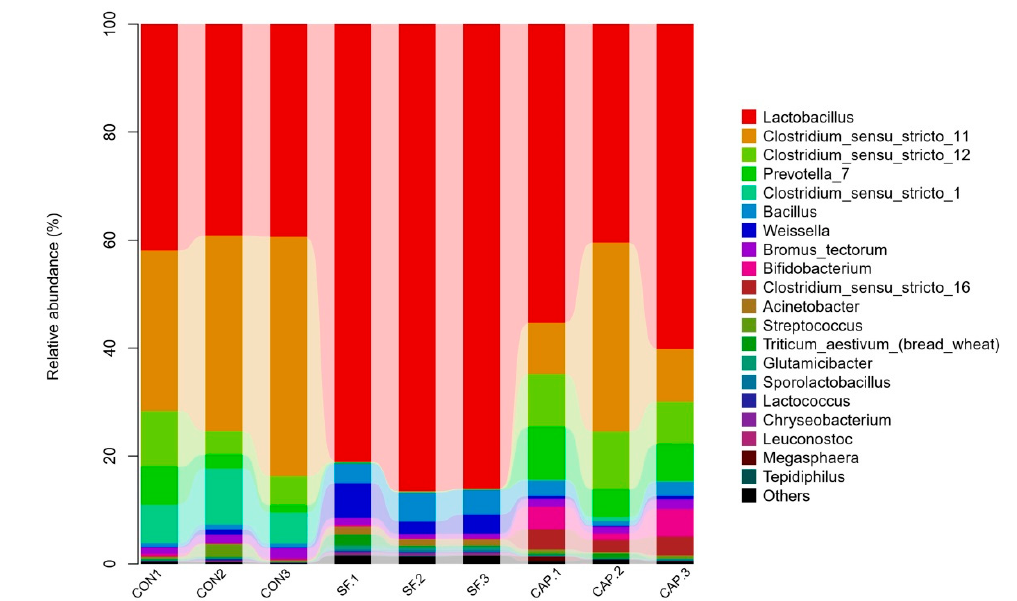
Figure 2. Bacterial community and relative abundance by genus of wet brewers grains ensiled with sodium formate and calcium propionate after 20 days (CON, control group; SF, sodium formate; CAP, calcium propionate; 1, 2, 3, three replicates for each treatment). Table 3. Relative abundance (%) of 10 most predominant genera isolated from wet brewers grains treated without (control) or with sodium formate, or calcium propionate and ensiled for 20 days.